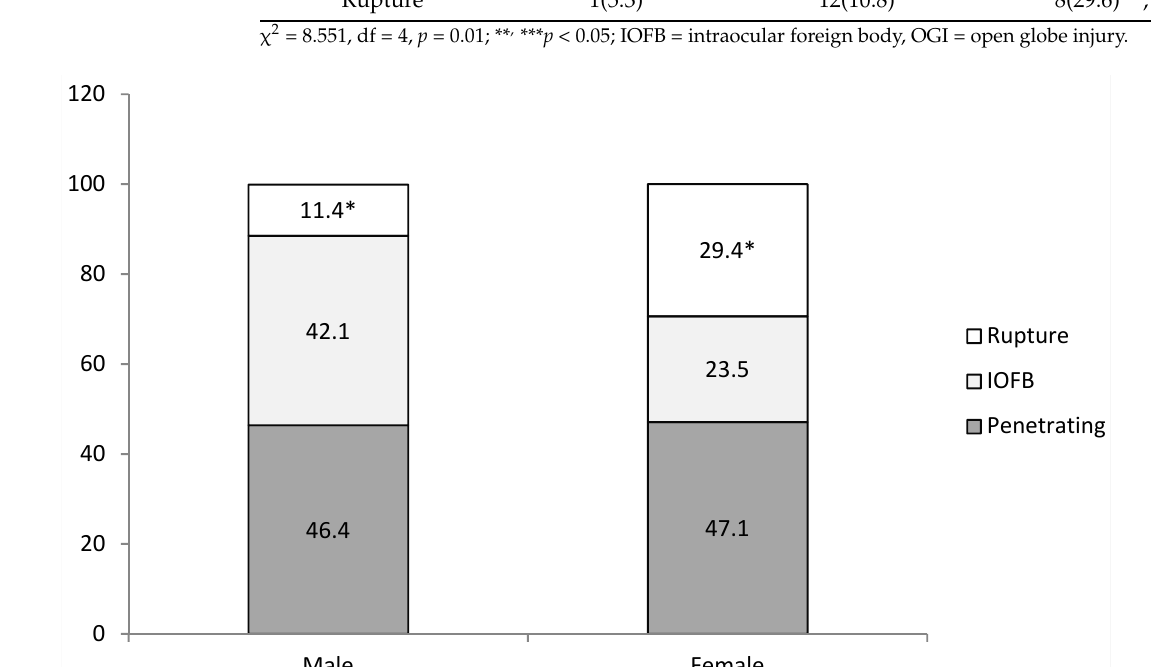
Figure 2. Distribution by gender and type of open globe injury (%). χ 2 = 5.114, df = 2, p < 0.05; * p = 0.017; IOFB = intraocular foreign body.